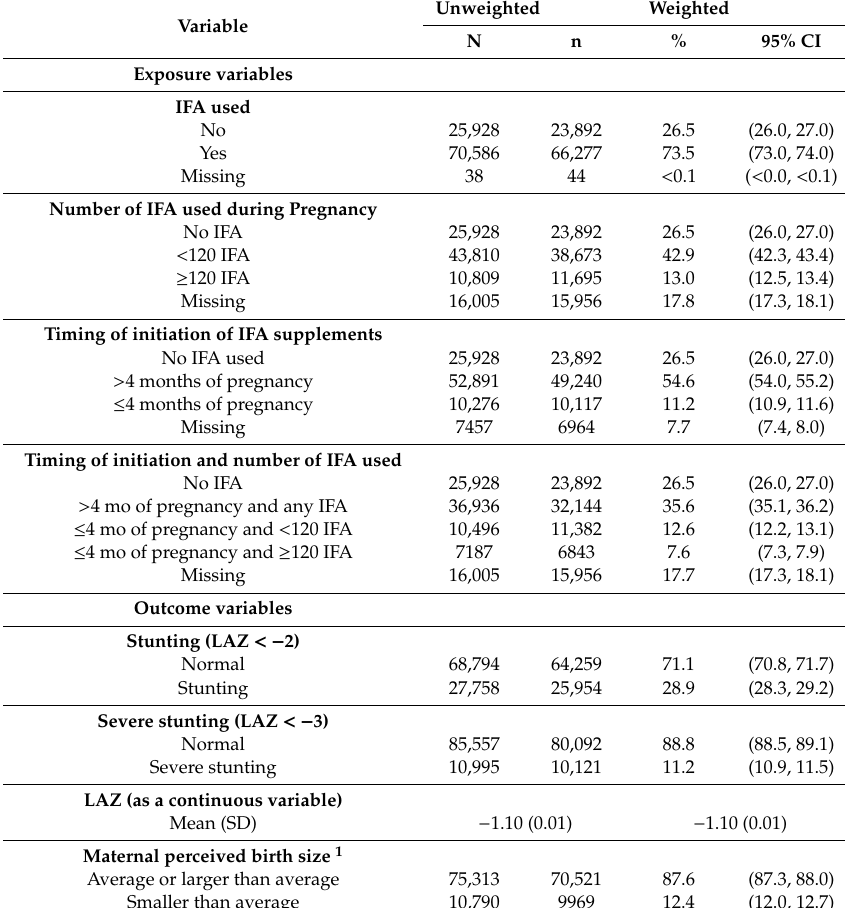
Table 4. Prevalence of study exposure and outcome variables of the most recent live-births two years before the interview, in South Asia,